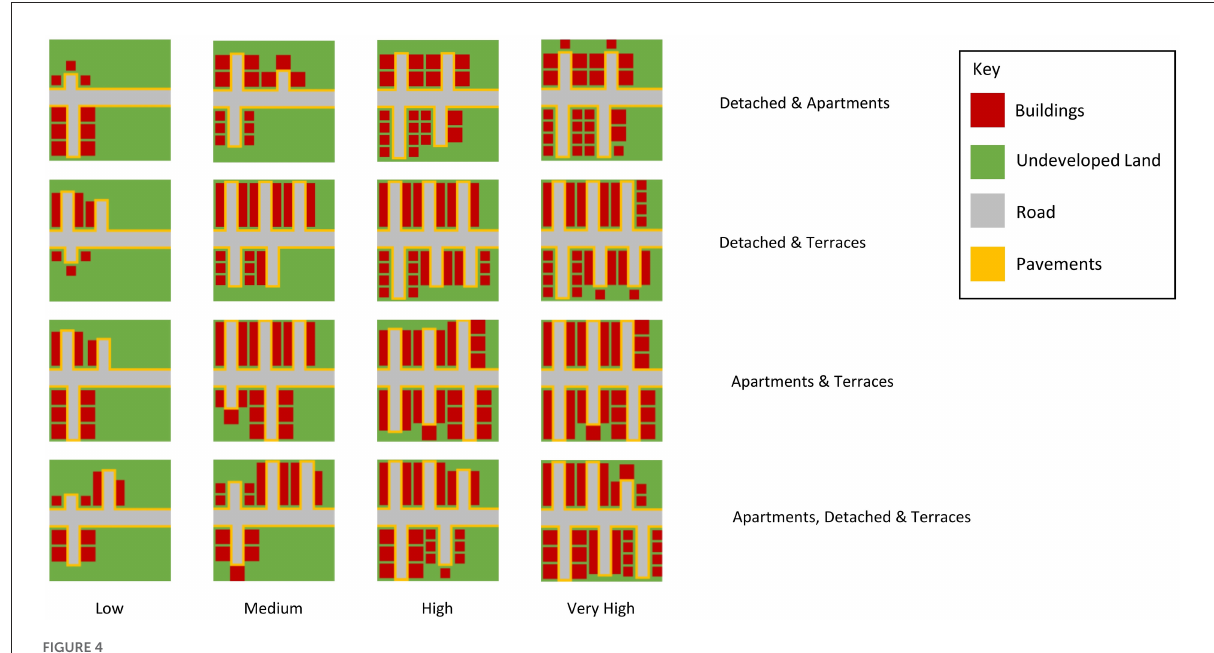
FIGURE4 The urban tile layouts used in the modeling.